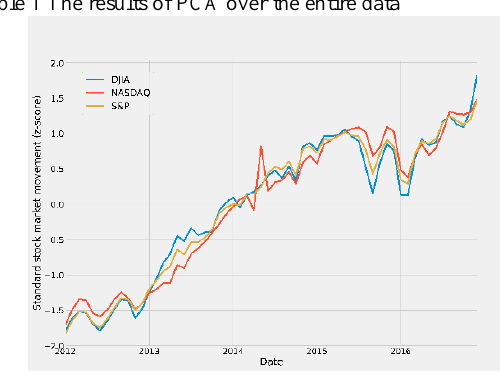
Figure 1 Values for three stock market